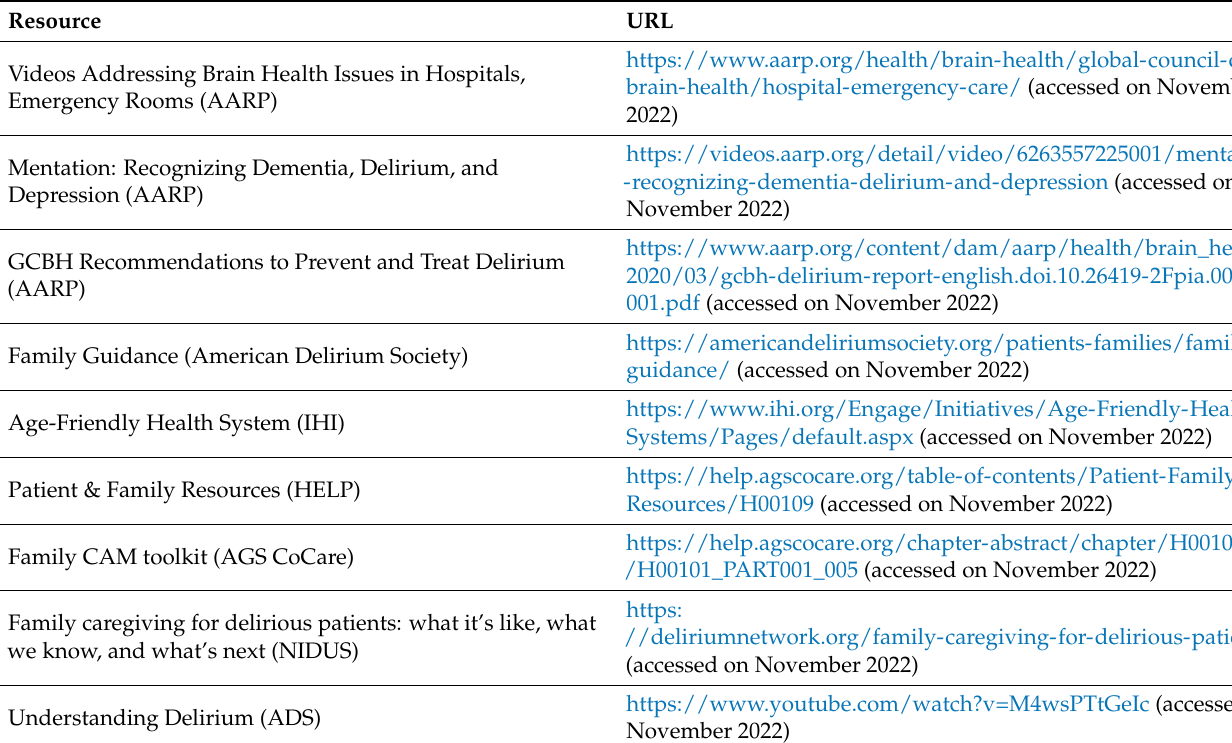
Table 3. Selected Resources and Education for Family Care